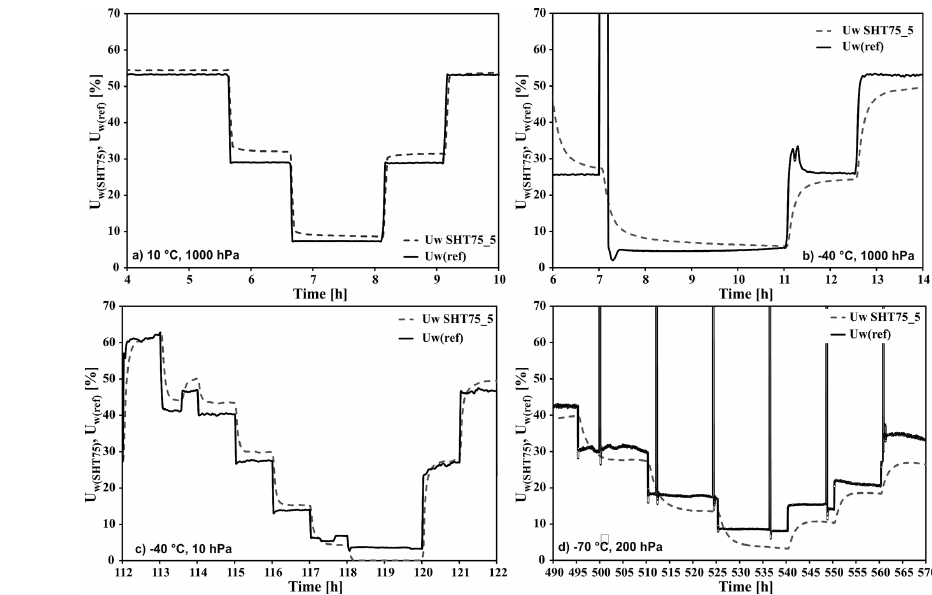
Figure 5. Signal of SHT75_5 (representative for all SHT75 sensors) at different temperatures and pressures.